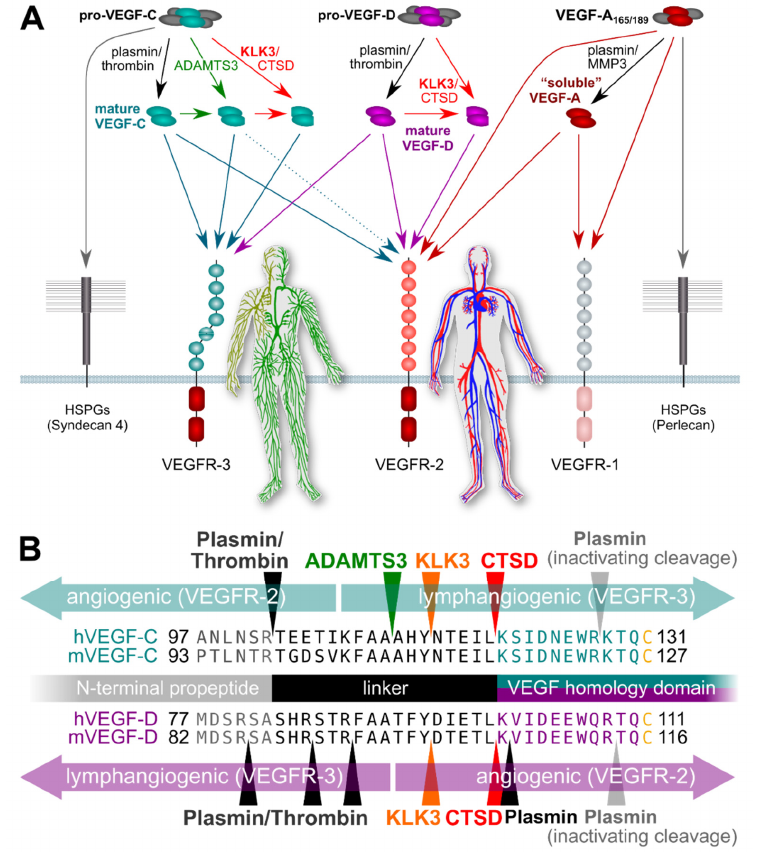
Figure 1. Simplified schematic of the proteolytic processing of VEGFs. ( A ) In vitro data on the prop- erties of different forms of mature VEGF-C and VEGF-D predict that KLK3 promotes lymphangio- genesis in tumors overexpressing VEGF-C, but angiogenesis in tumors overexpressing VEGF-D. Lymphangiogenesis is mediated via VEGFR-3, and progressive proteolytic processing renders VEGF-C selective for VEGFR-3. Unlike VEGF-C, VEGF-D can become exclusively angiogenic upon proteolytic processing [75]. VEGF-C- and VEGF-D mediated lymphangiogenesis could enhance tu- mor immune surveillance during the early stages of tumor development but promote metastasis (VEGF-C) or tumor angiogenesis (VEGF-D) during later stages. In the absence of proteolytic pro- cessing, the longer isoforms of VEGF-A, pro-VEGF-D and pro-VEGF-C are sequestered on cell sur- face heparan sulfate proteolglycans (HSPGs) and in the extracellular matrix. ( B ) The locations of proteolytic processing for proteases known to cleave VEGF-C and/or VEGF-D. Note that the pro- cessing sites for plasmin and thrombin for VEGF-D have not been experimentally determined and are only predicted based on the known cleavage specificities. A recent analysis of interactions between KLK3 single nucleotide polymorphisms (SNPs) and other SNPs to identify interactions associated with prostate cancer aggressive- ness support the notion that KLK3 and VEGF-C concertedly are involved in the regulation of prostate cancer tumor angiogenesis. Although not common, the VEGFC/KLK3 SNP– SNP interaction pair rs174776/rs3775202 was highly significantly associated with prostate cancer aggressiveness [76]. Since both SNPs are intronic and not predicted to change